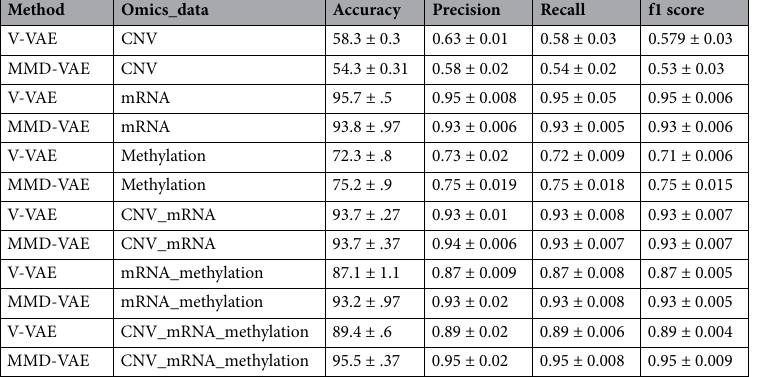
Table 2. Molecular subtypes classification performances using LFs learned via supervised